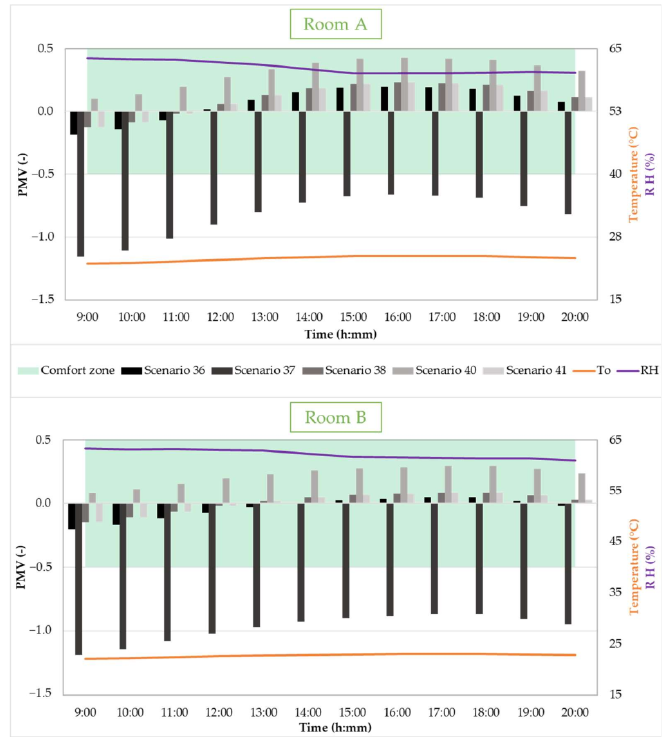
Figure 8. Hourly operative temperature, relative humidity, and PMV in rooms A and B with an out-of-bed patient: different scenarios in the spring day.